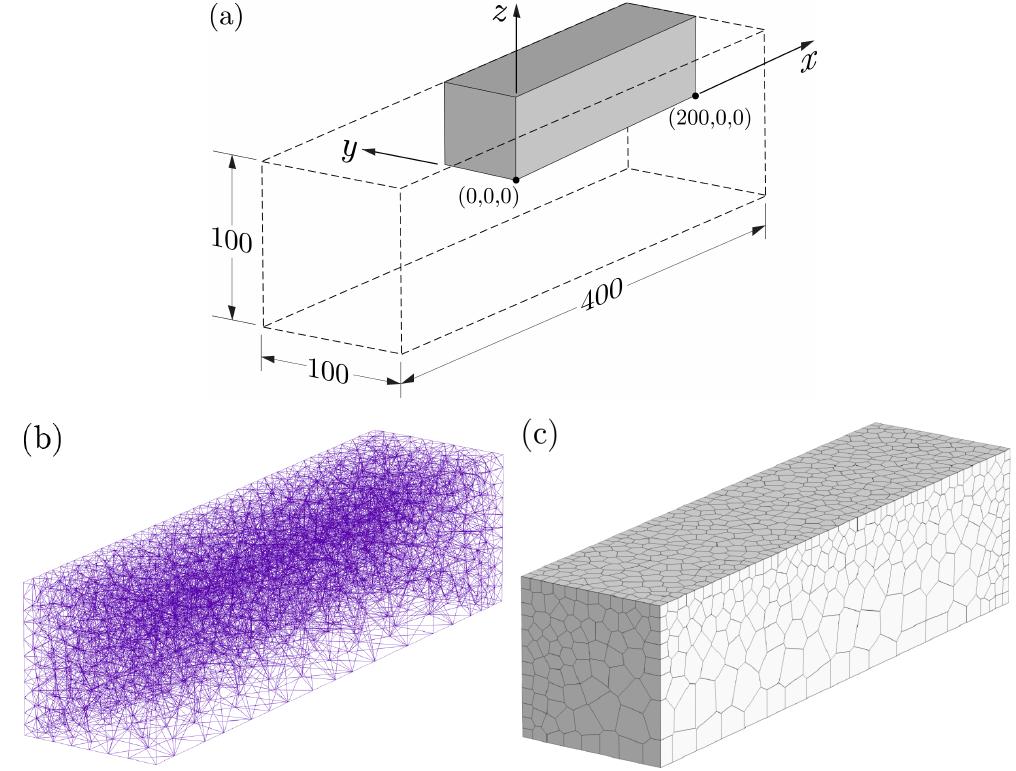
Figure 10. Discretization for shrinkage test simulations: ( a ) dimensions (in mm); ( b ) lattice representation; and ( c ) volume rendering of a symmetric portion of the prism